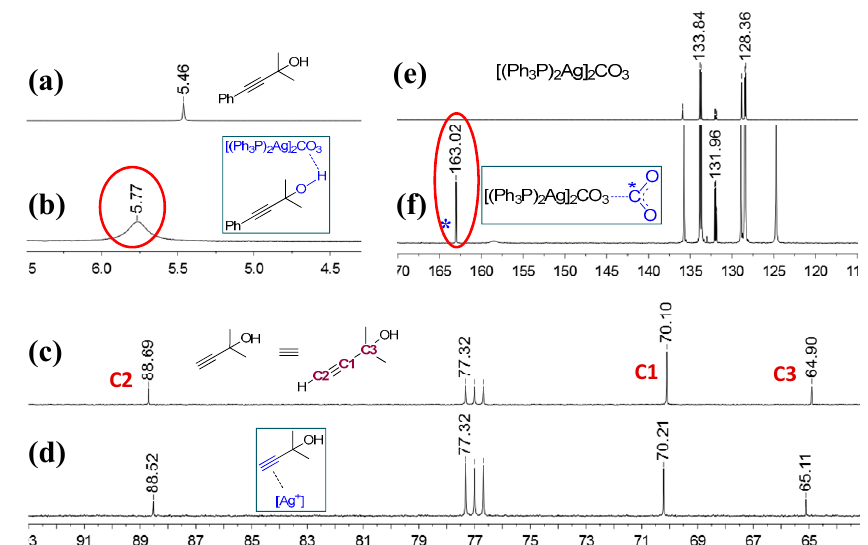
Figure 2. 1 H-NMR ( a , b ) and 13 C-NMR ( c – f ) investigation. ( a , b ) 2-Methyl-4-phenylbut-3-yn-2-ol (8.0 mg), Ag 2 CO 3 (2.8 mg) and Ph 3 P (10.5 mg) ([D 6 ] DMSO 0.6 mL). ( c , d ) 2-methylbut-3-yn-2-ol (20.2 mg),